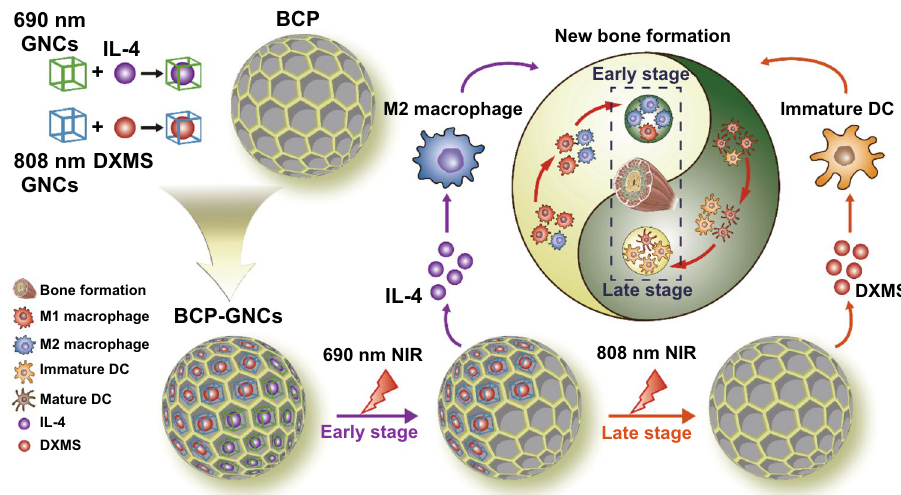
Fig. 7 Gold nanocages (GNCs) modification of BCP according to the immune response characteristics of macrophages and DCs and controlled release of IL-4 at the early stage implantation and DXMS at the late stage facilitate macrophage M2 polarization and inhibition of DC matura- tion to promote materials-mediated new bone